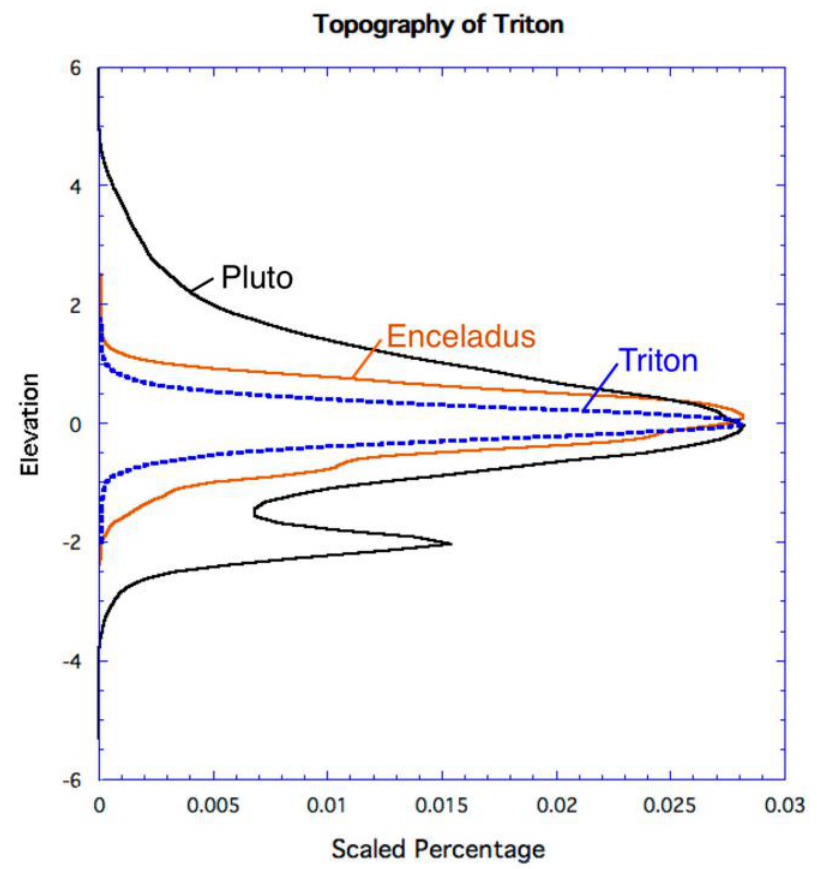
Figure 33. Provisional hypsogram of Triton topography based on SG_PC_DEM data. The Triton hypsogram is dashed to highlight its provisional and incomplete nature, covering only ~5% of the surface. Note that the Enceladus data [64] are global in scope and the Pluto data [19] cover ~40% of the surface, though these areas sample all known major terrain types. The Triton data do represent significant areas of three major terrain types (cantaloupe terrain, volcanic plains, and etched plains), while sparse southern hemisphere elevation data suggest similar